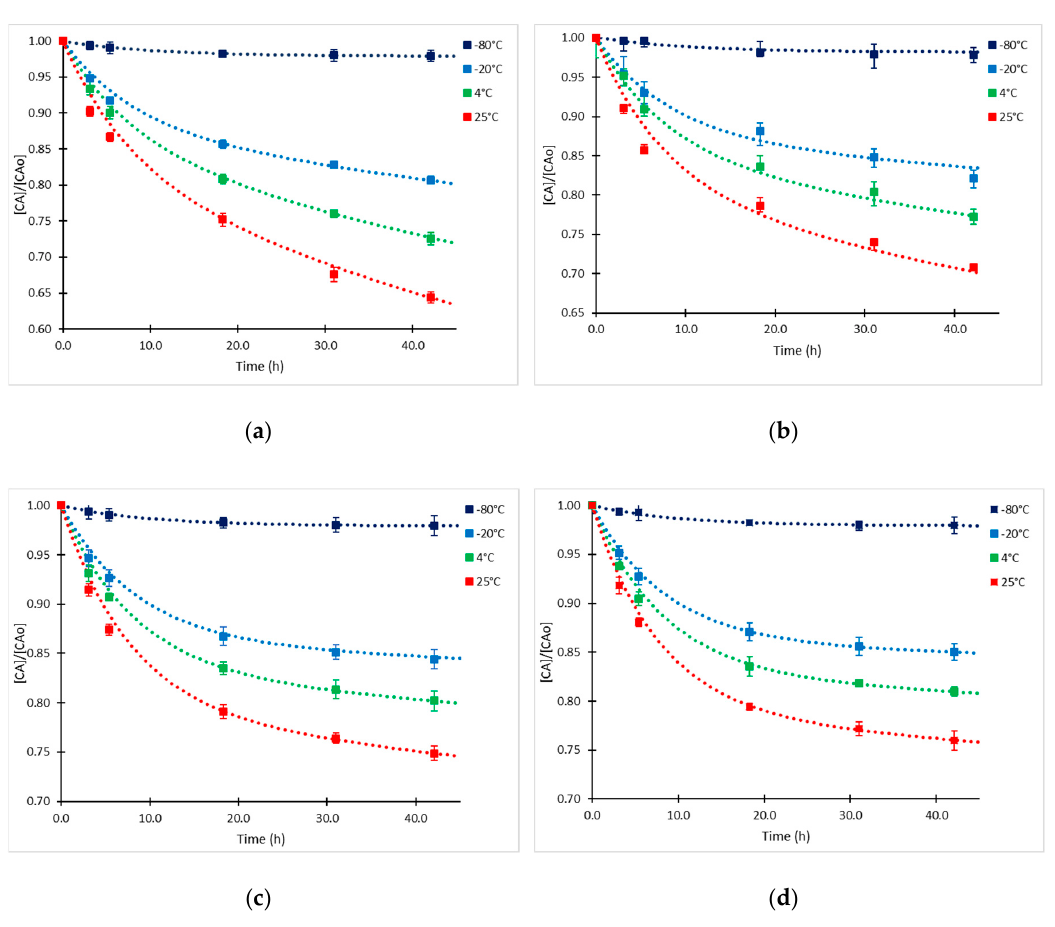
Figure 6. Experimental points (squares) and model prediction (dashed line) of CA degradation at − 80, − 20, 4 and 25 °C. ( a ) CA o = 126.7 mg/L; ( b ) CA o = 65.5 mg/L; ( c ) CA o = 25.3 mg/L; and ( d ) CA o = 16.3 mg/L.